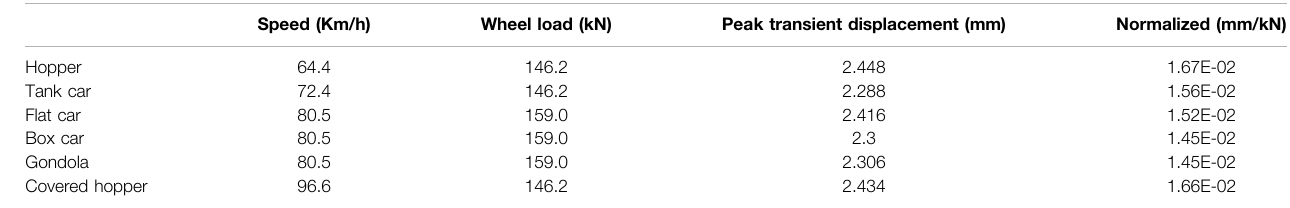
TABLE 2 | Peak rail displacement comparison between freight trains at